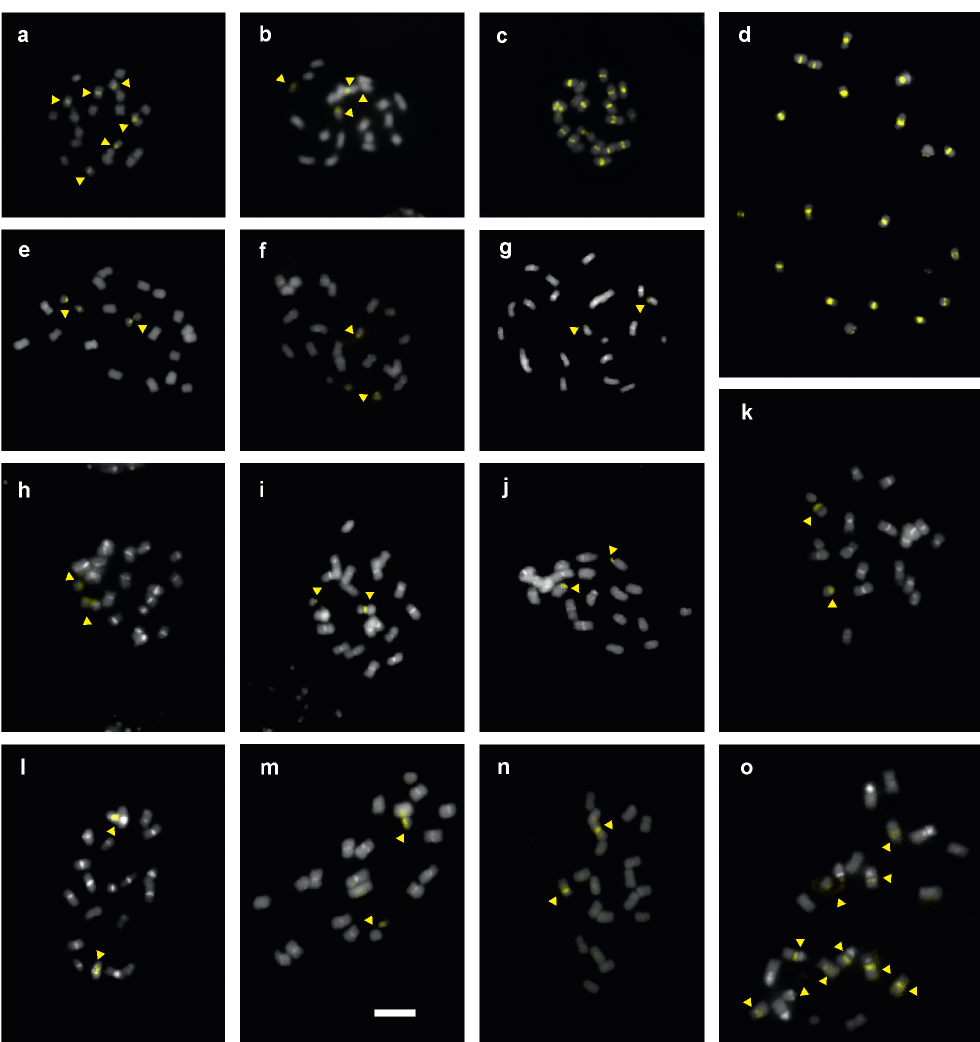
Figure 3. Somatic metaphases of Arachis species belonging to different sections after CMA/DAPI banding technique. The yellow signals correspond to CMA heterochromatin bands and the white signals to DAPI heterochromatin bands. a- A. triseminata (Triseminatae); b- A. dardani (Heteranthae); c- A. pusilla V13189 (Heteranthae); d- A. pusilla VFaPzSv 13107 (Heteranthae); e- A. pintoi (Caulorrhizae); f- A. repens (Caulorrhizae); g- A. benthamii (Erectoides); h- A. duranensis (Arachis, A genome); i- A. vallsii (Procumbentes); j- A. matiensis (Procumbentes); k- A. praecox (Arachis, G genome); l- A. batozocoi (Arachis, K genome); m- A. trinitensis (Arachis, F genome); n- A. ipaënsis (Arachis, B genome); o- A. glandulifera (Arachis, D genome). The yellow arrows point some weak CMA bands. Scale bar 5